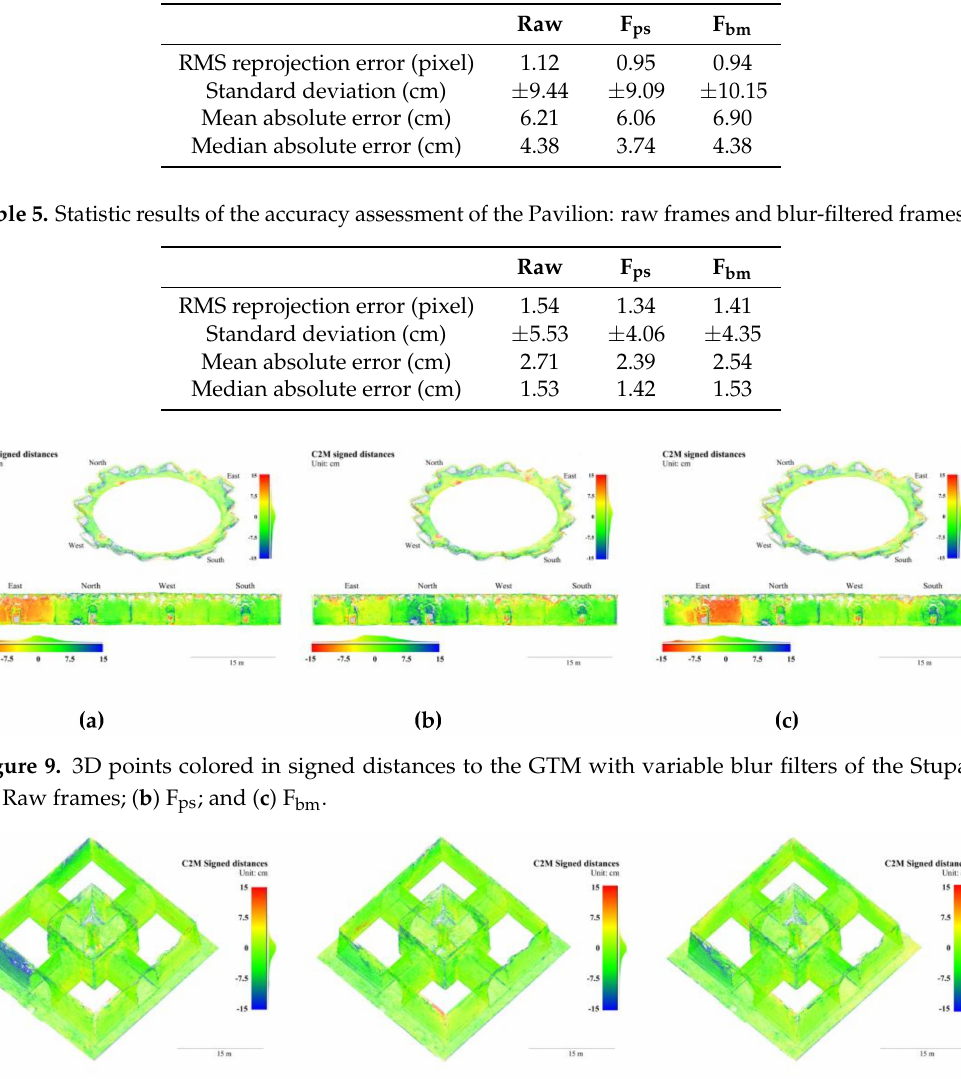
Table 4. Statistic results of the accuracy assessment of the Stupa: raw frames and blur-filtered frames.